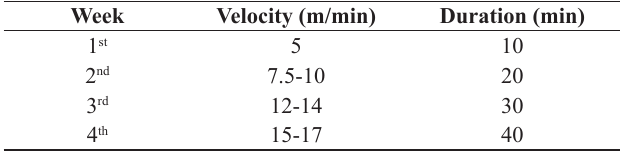
Table 1: Adaptation to the aerobic training